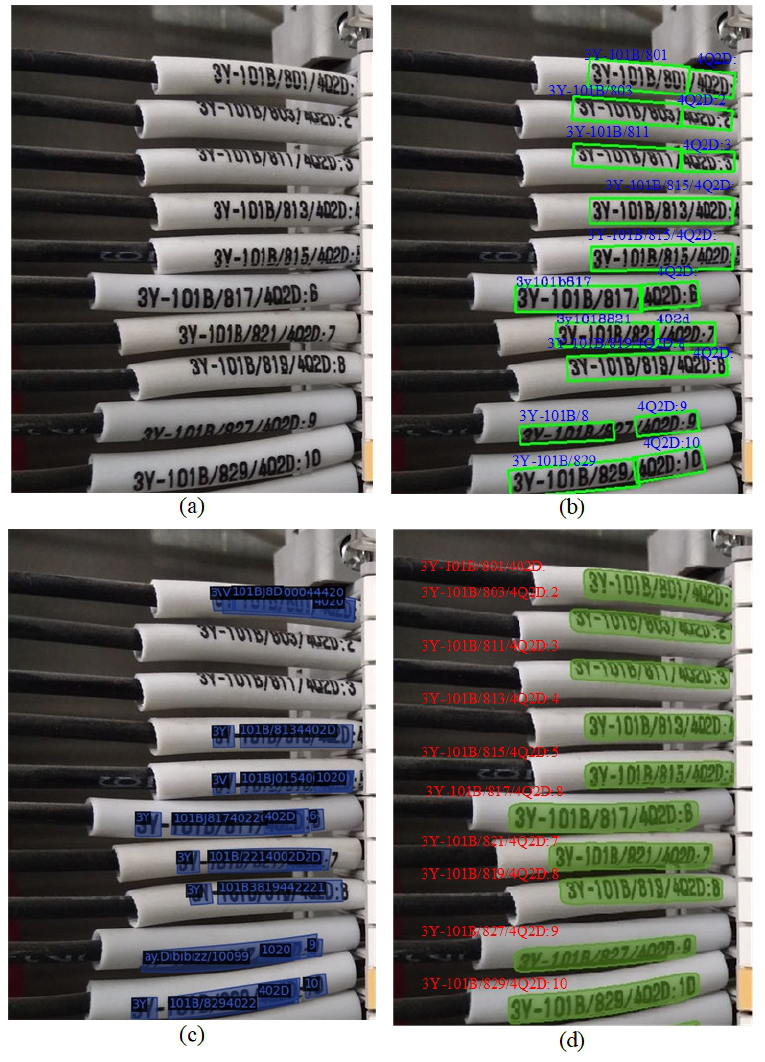
Figure 1. Our spotting results compared with state-of-the-art approaches for the dense scene text image. ( a ) is the input image. ( b ) is the result of Pan++ [10]. ( c ) is the result of ABCNet v2 [5]. ( d ) is the result of our Rwin-FPN++